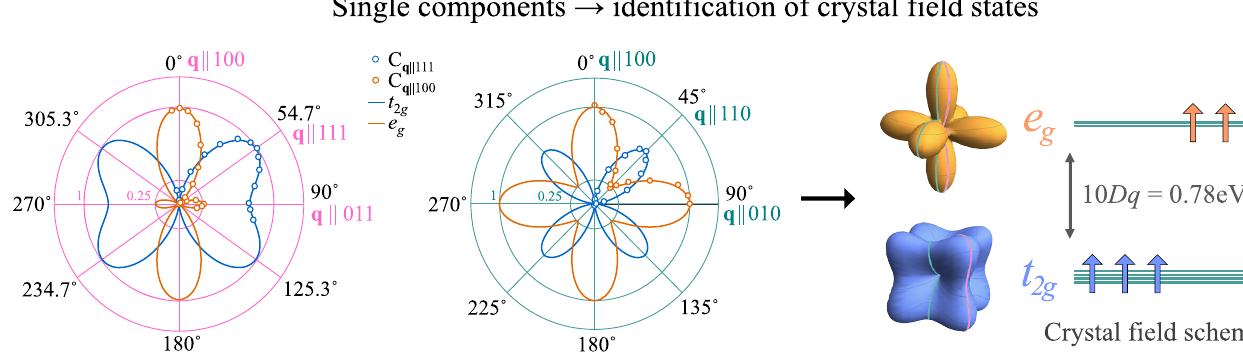
=t 2 (orange) and t 2 (blue) orbitals, respectively. The e energy g g g g